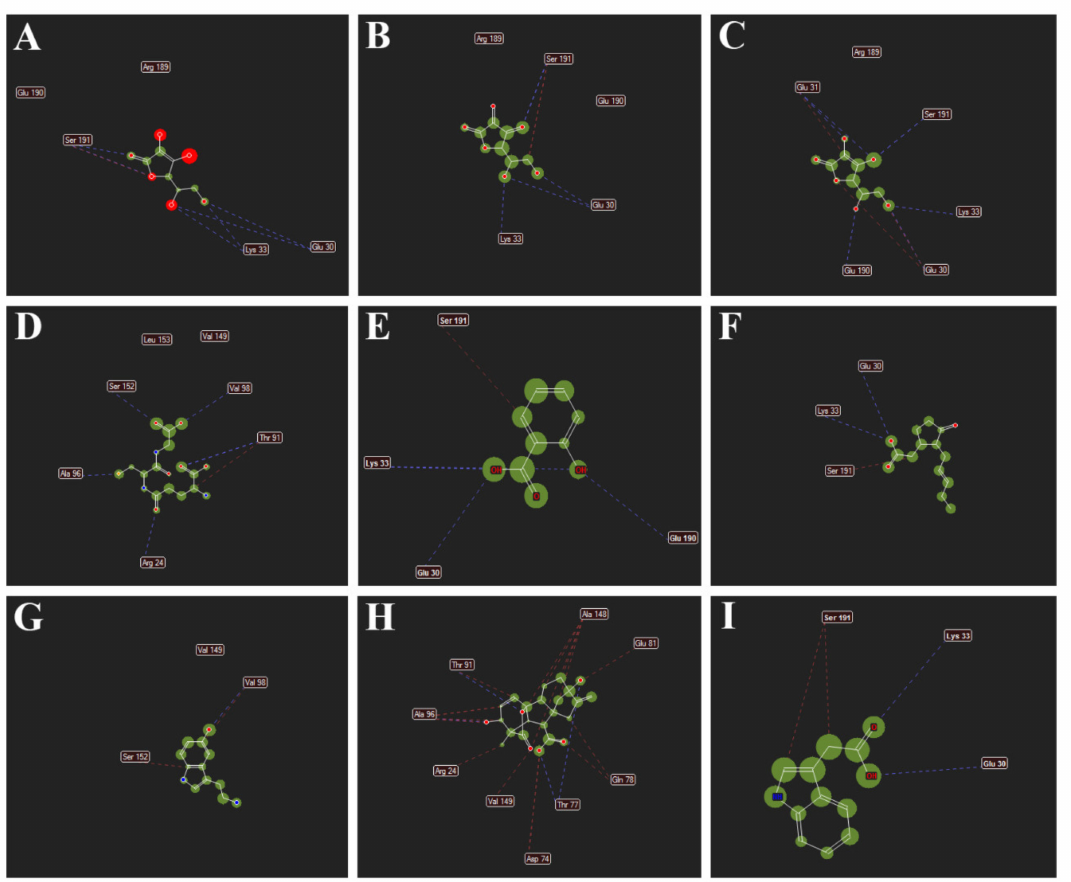
Figure 7. Interactions of different metabolites ( A ) MDHA; ( B ) DHA; ( C ) AsA; ( D ) GSH; ( E ) SA; ( F ) JA; ( G ) 5-HT; ( H ) GA3 and ( I ) IAA with Ta DHAR. The amino acids shown are the ones with which the metabolites form hydrogen bonding and stearic